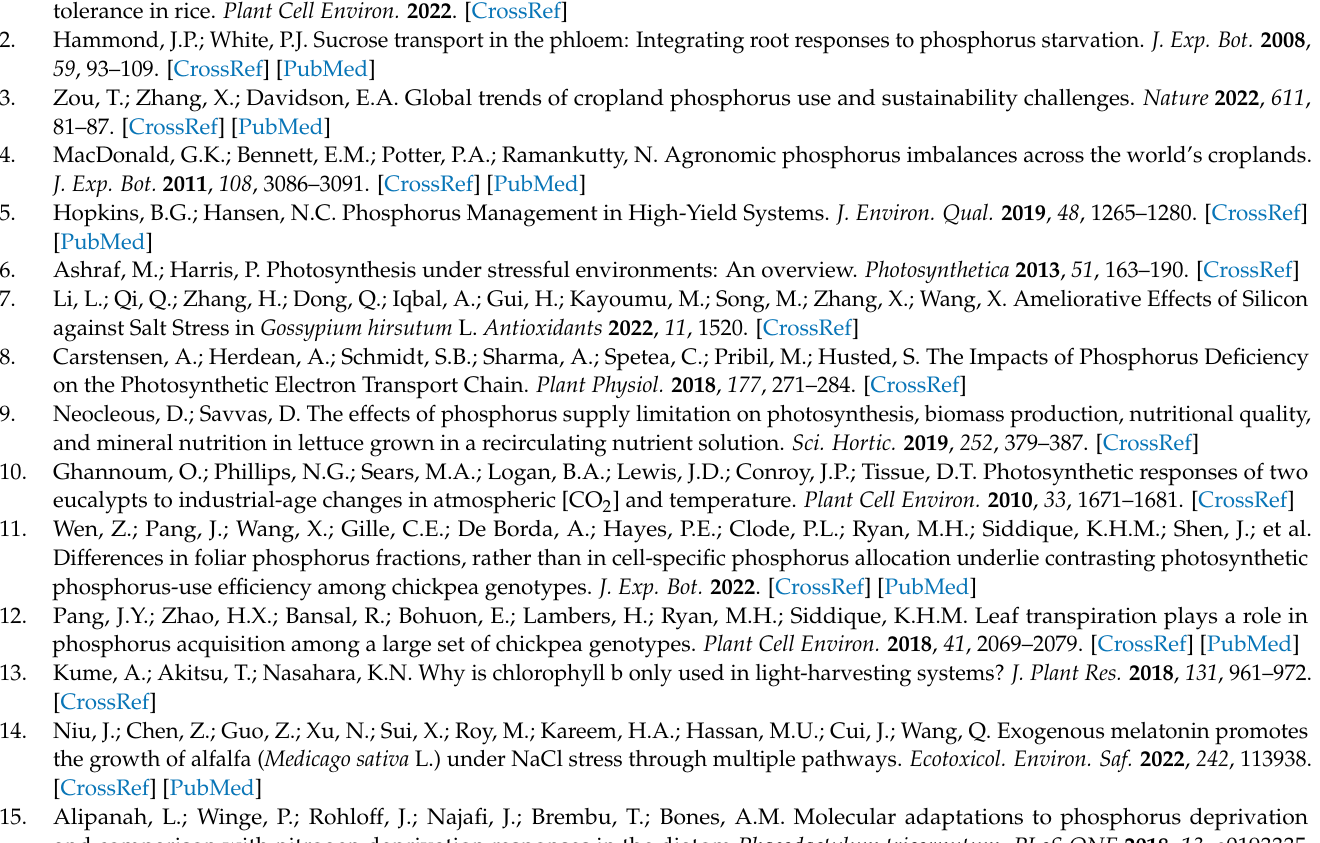
under different phosphorus treatments. Table S6: Global ANOVA of various characteristics in different phosphorus